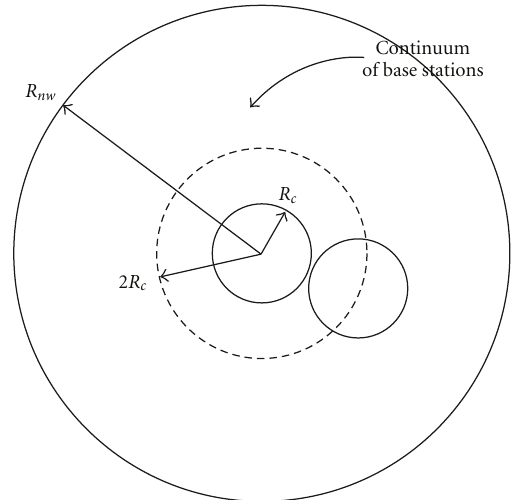
Figure 1: Network and cell of interest in the fluid model; the minimum distance between the BS of interest and interferers is 2 R c and the interfering network is made of a continuum of base